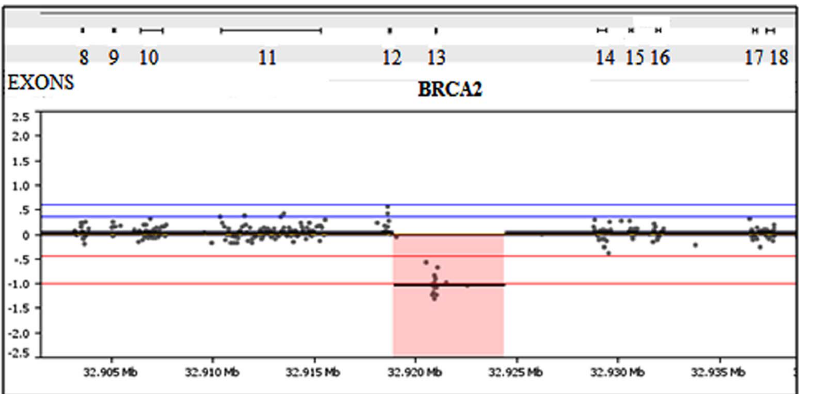
Figure 4. Microarray has exon level resolution for deletion and duplication variant detection. A sample harboring a 2 Kb exon 13 deletion in BRCA2 was detected using the custom designed microarray.